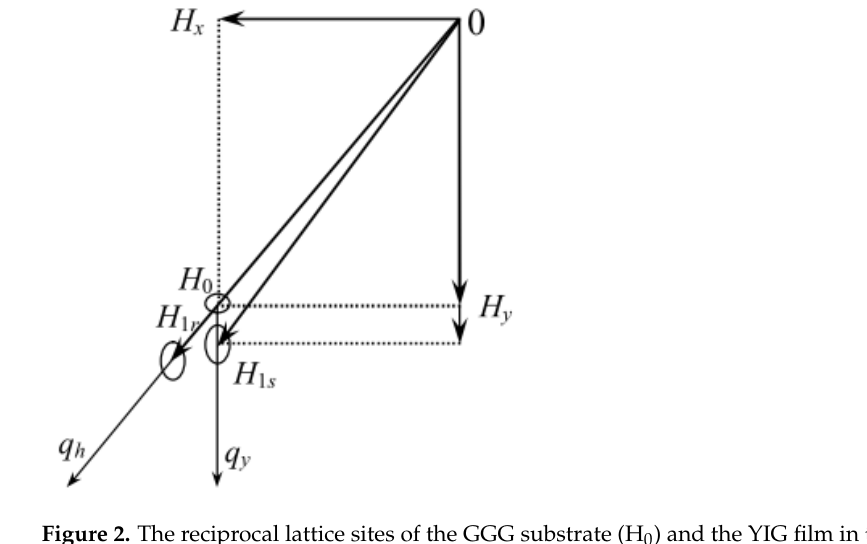
Table 1. RSMs for YIG/GGG films implanted with Ne + ions ( Е =82 keV) with doses of 0, 1 × 10 14 , 2 × 10 14 and 4 × 10 14 сm −2 obtained for (444), (888) and (880) reflexes.